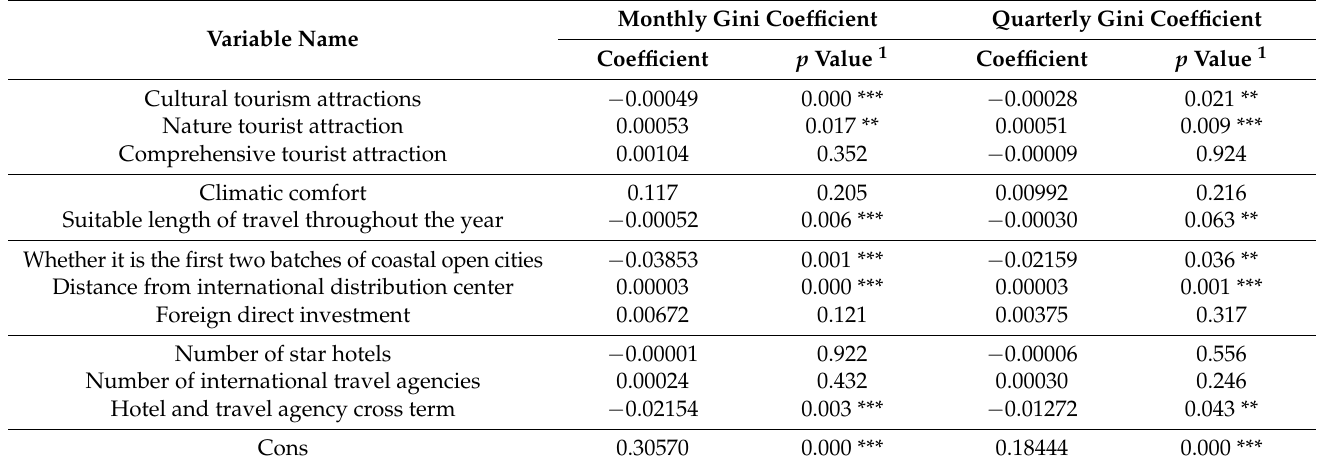
Table 2. Regression results of factors influencing seasonal changes on a monthly and quarterly